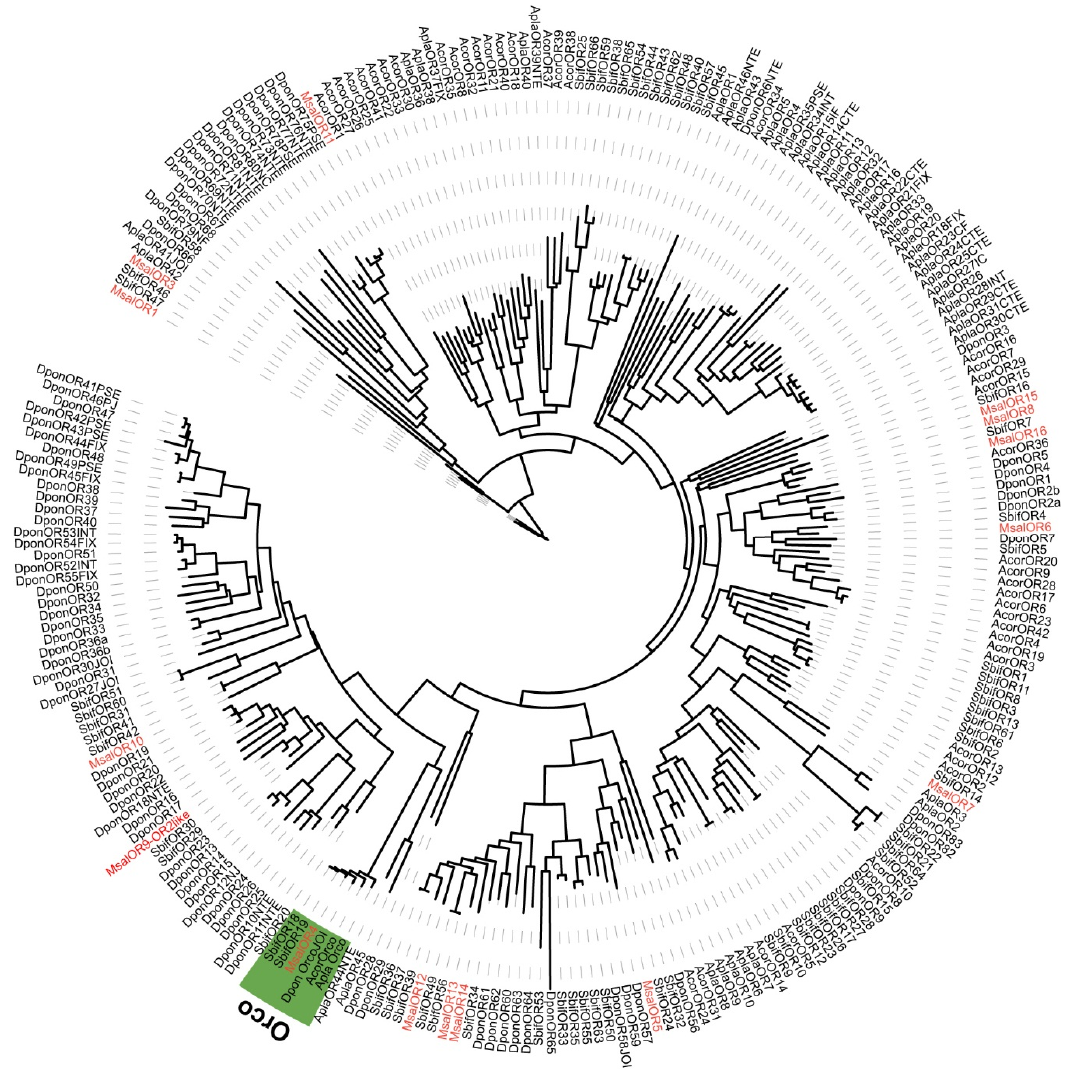
Figure 6. Maximum likelihood dendrogram based on protein sequences of candidate olfactory receptors (OR) in M. saltuarius and orthologs from other Coleopteran insects. JTT + F + R6 model based on the best fit result of IQ-tree model finding, and bootstrap consensus tree inferred from 1000 replicates were used. Monochamus saltuarius (Msal) (red), S. bifasciatus (Sbif), A. corpulenta (Acor), A. planipennis (Apla), and D. ponderosae (Dpon). Orco clade marked with green